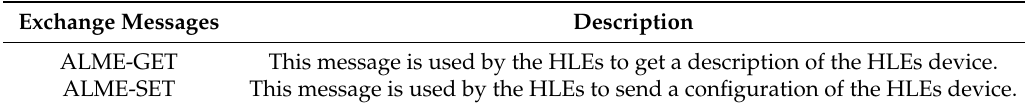
Table 1. Exchanged messages at the Abstraction